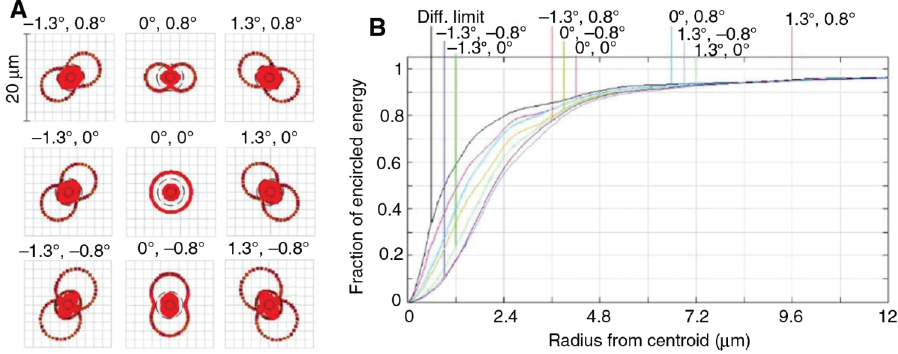
Figure 16: Telescope image quality – curved FOV. (A) Spot diagram. (B) Diffraction encircled energy. Results from Zemax modeling and spot diagram show that the maximum RMS blur residuals is ϕ 5.5 μ m or d = 1.27 arcsec. On the other hand, from eq. (5) [11], a same diagonal semi-FOV (1.52°), and NC